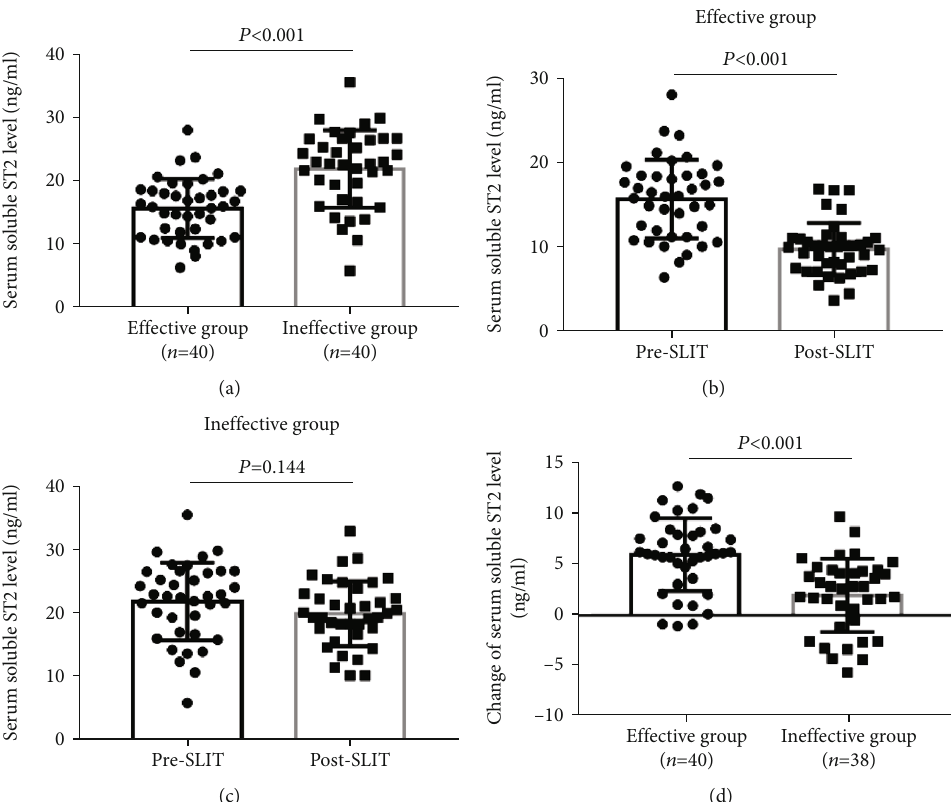
Figure 3: The serum levels sST2 in the e ff ective group and ine ff ective group. (a) The sST2 levels were lower in the e ff ective group than in the ine ff ective group; (b) patients in the e ff ective group exhibited signi fi cantly lower sST2 levels post-SLIT than pre-SLIT; (c) no statistical di ff erence was observed in the ine ff ective group between post-SLIT and pre-SLIT. (d) the change of sST2 levels was higher in the e ff ective group than in the ine ff ective group. sST2: soluble suppressor of tumorigenicity 2; SLIT: sublingual immunotherapy.